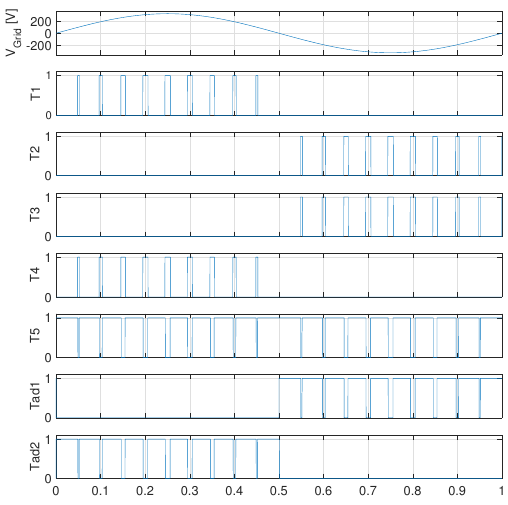
Figure 9. PWM modulation of the proposed CSI5 topology.